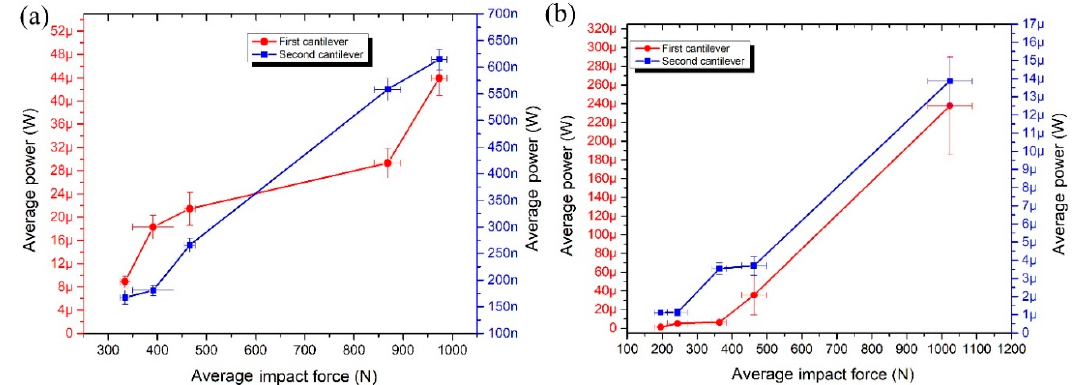
Figure 19. An average open circuit voltage per 1N.